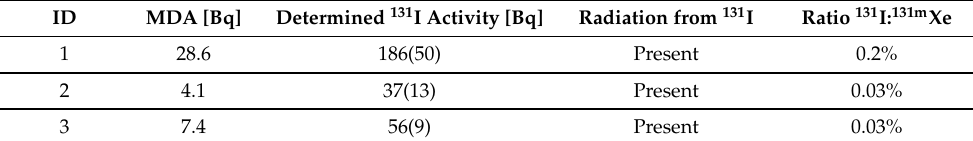
Table 3. Minimum detectable activity of 131 I in the 131m Xe collection